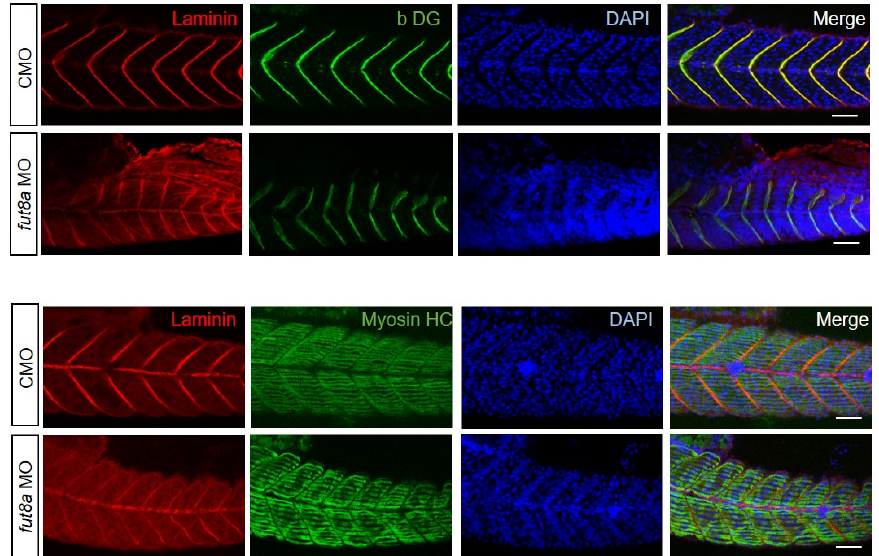
Figure 2. Reduced fut8a in zebrafish triggers skeletal abnormalities anti-laminin, anti-beta-dystroglycan ( β DG), anti-myosin heavy chain (Myosin HC), and DAPI. Scale bar: 50 μ m.